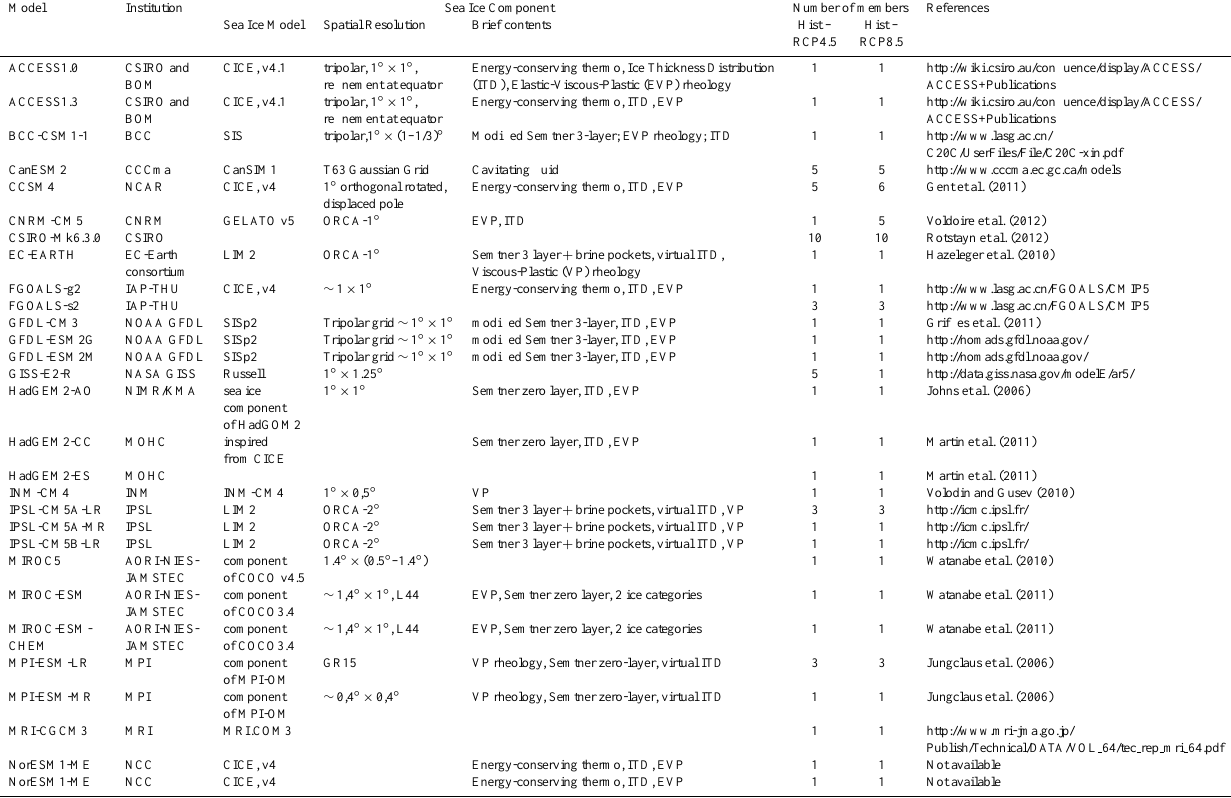
Table 1. The 29 CMIP5 models used in the study, and the principal characteristics of their sea ice components.